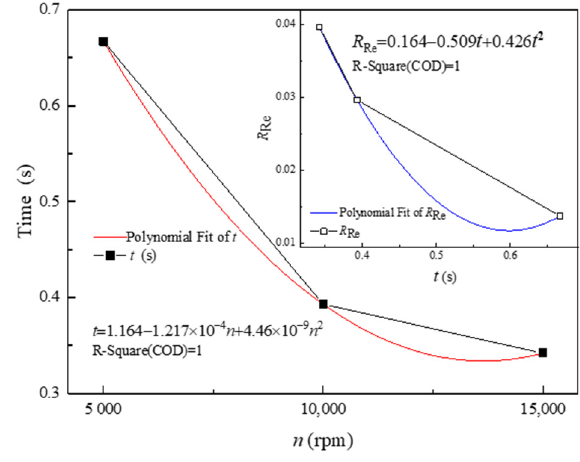
Figure 8. Fitting of rotor speed ( n ) and time ( t ) with R Re . Table 2. Comparison between the simulated results and calculated values of Equation (23).